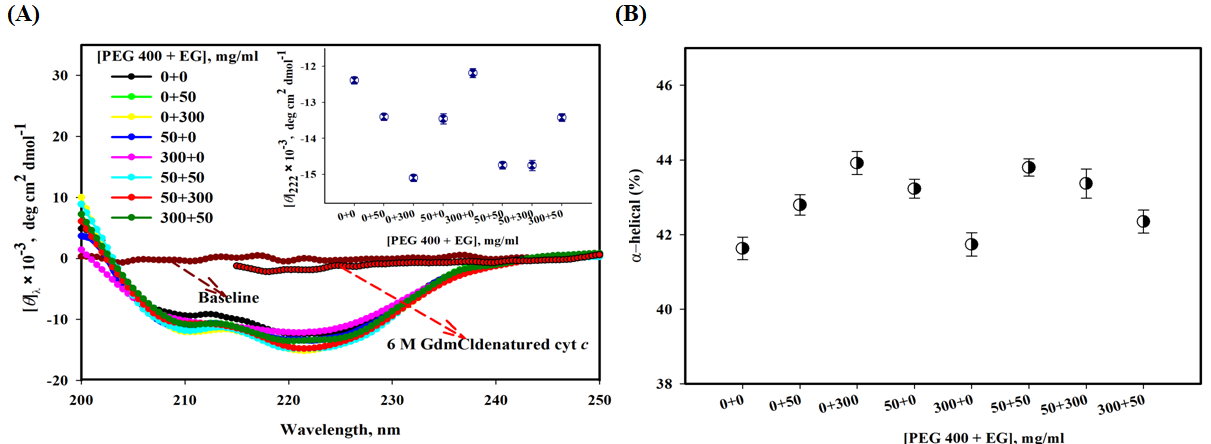
Figure 2. ( A ) Far-UV CD spectra of cyt c with different [PEG 400 + EG], and 6 M GdmCl at pH 7.0 and 25 ◦ C.The inset of the figure displays a plot of [ θ ] 222 versus [PEG 400 + EG]. ( B ) α -helical content of cyt c in the presence of mixtures of crowders.